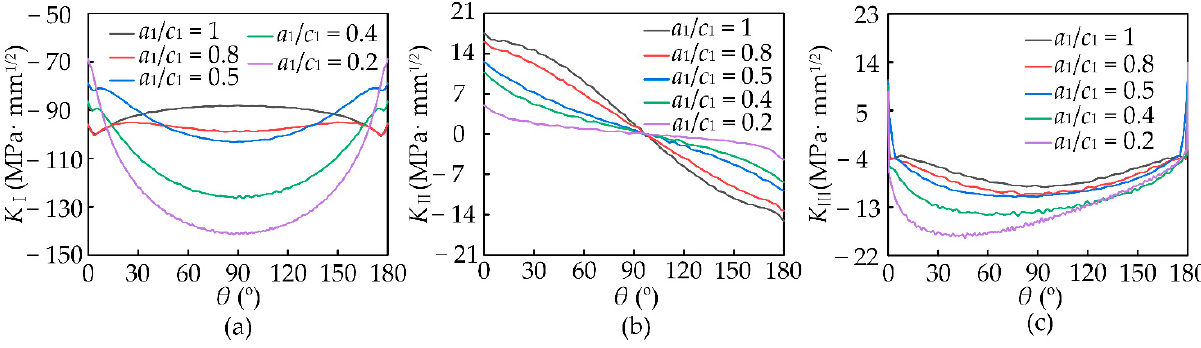
Figure 6. Distribution of the SIF with different shape ratios: ( a ) K I , ( b ) K II , and ( c ) K III .